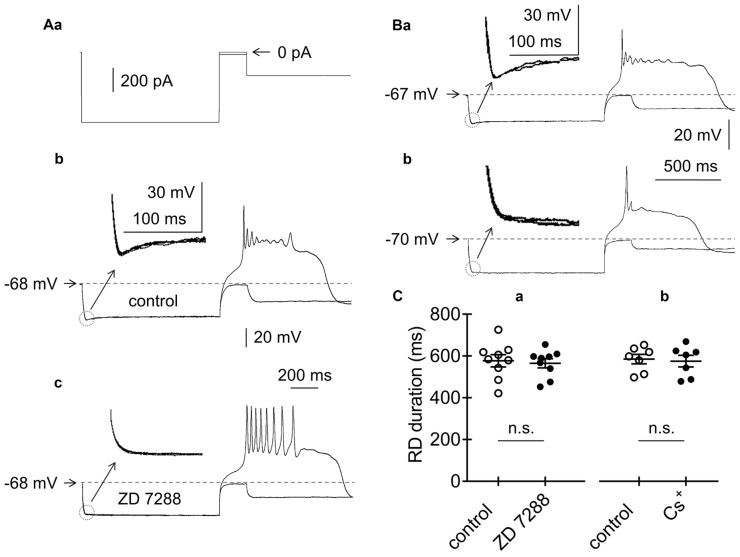
Effects of HCN channel blockers on RD in the absence of Ca++ in the extracellular solution. (Aa) Current protocol applied to evoke the membrane potential changes shown in (b,c) (compare to Figure 1Aa). RD evoked before (b) and during (c) bath application of ZD 7288 (50 μM). Insets to (b,c) show amplified voltage responses to the beginning of the rectangular hyperpolarizing current steps. Voltage sag was present before (inset to b) and was absent during bath application of ZD 7288 (50 μM, inset to c). (B) Examples of RDs evoked in two pyramidal neurons, in which voltage sag was present (a) and absent (b). Insets show amplified voltage responses to the beginning of the rectangular hyperpolarizing current steps. The current protocol applied to evoke RD is shown in Figure 1Aa. (C) Duration of RD before (control) and after 15-min bath application of either ZD 7288 (a, ZD 7288, 50 μM) or Cs+ (b, Cs+, 3 mM); n.s., non-significant.